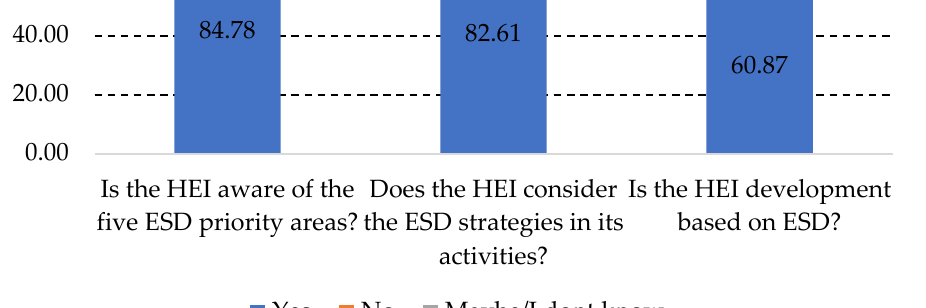
Figure 2. State of ESD in HEIs—general view.